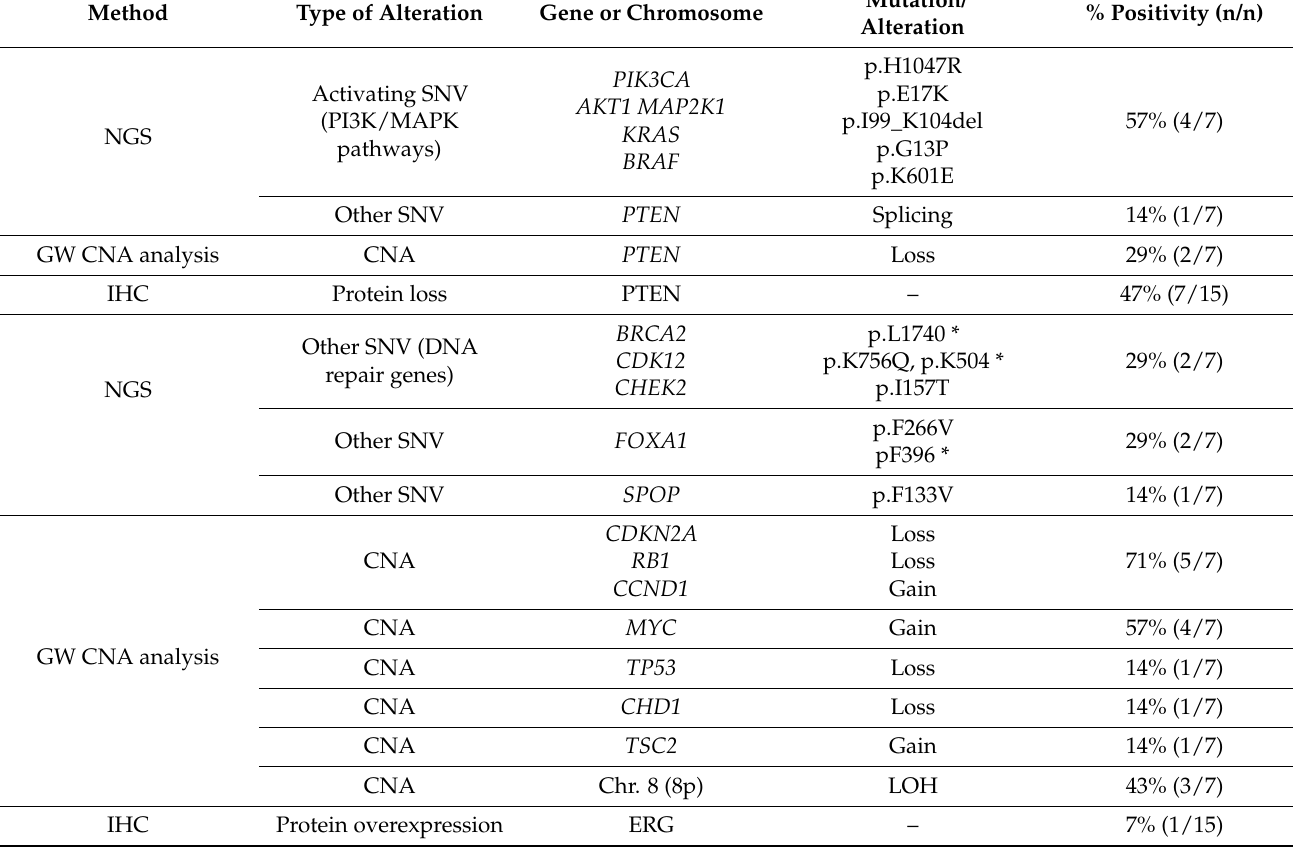
Table 1. Overview of the study [63] describing IDC-P without associated invasive carcinoma in radical